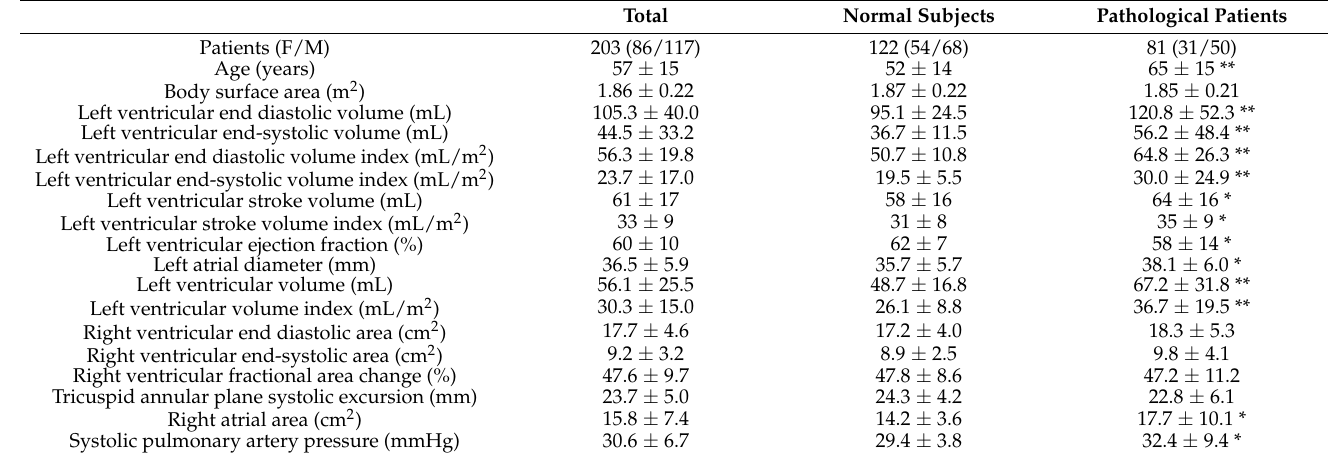
Table 1. Demographic and two-dimensional echocardiographic characteristics of study population.